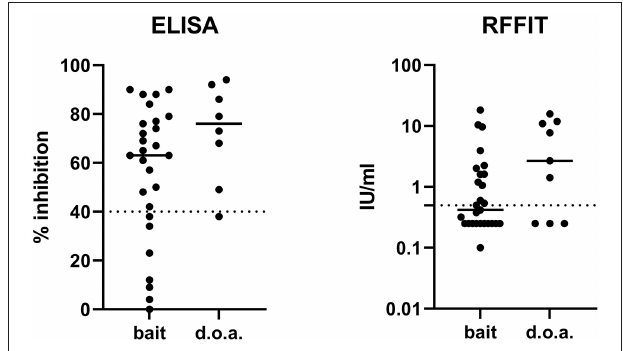
FIGURE 1 | The immune response measured by ELISA (rVBA) and RFFIT (rVNA) after oral bait or direct oral administration (d.o.a.). Of several samples that tested negative in RFFIT, no exact value could be estimated ( < 0.5 IU/ml); thus, an average value of 0.25 IU/ml (range 0–0.5 IU/ml) was set for these samples. The solid lines indicate the means of the measured values in ELISA and RFFIT, while the cut-off levels for both serological tests are indicated by the dashed lines. ELISA, enzyme-linked immunosorbent assay; rVBA, rabies-specific binding antibodies; RFFIT, rapid fluorescence focus inhibition test; rVNA, rabies virus-neutralizing antibody.